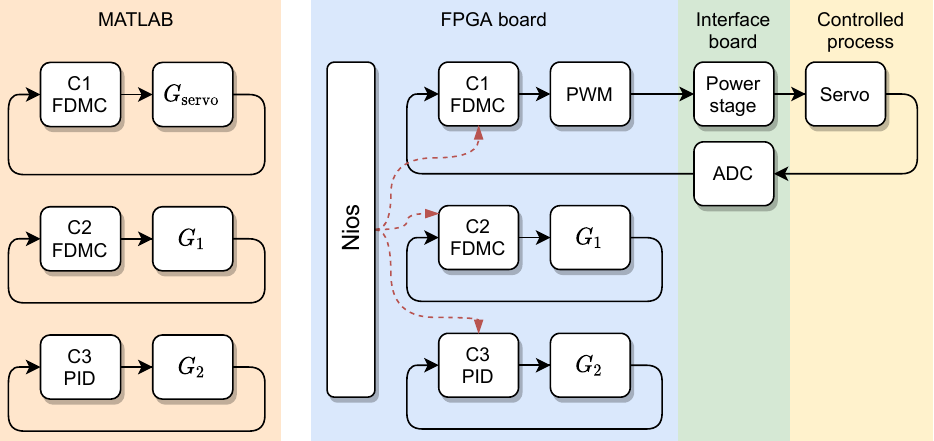
Figure 12. The structure of control loops in the simulated (MATLAB) environment ( left ) and FPGA with servomotor as a process of control ( right